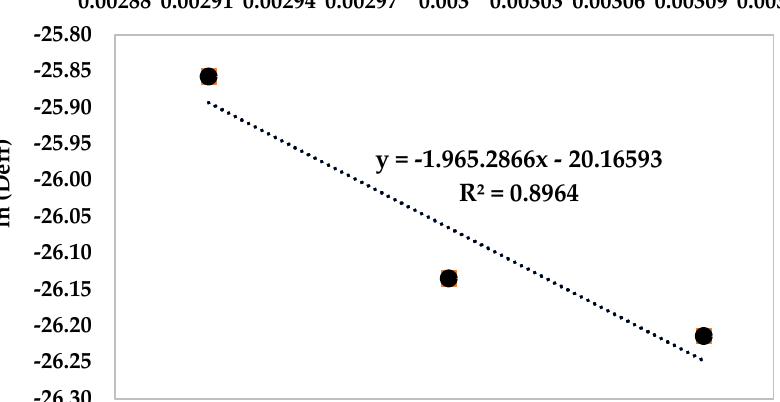
Figure 4. Relationship between IRD temperature and effective moisture diffusivity.